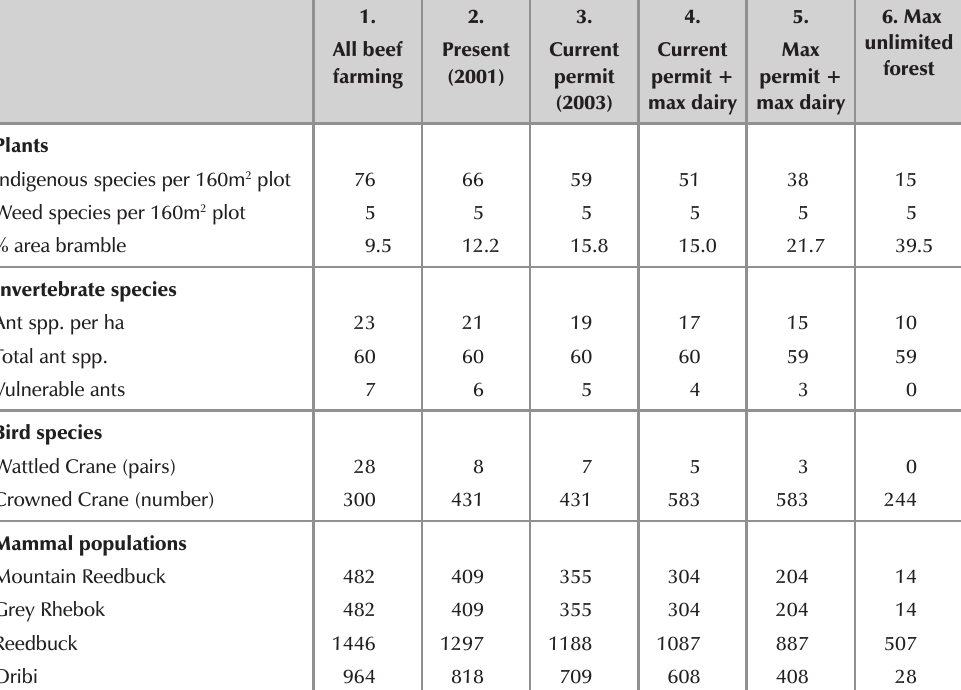
Estimated biodiversity impacts of different land use scenarios for Underberg district